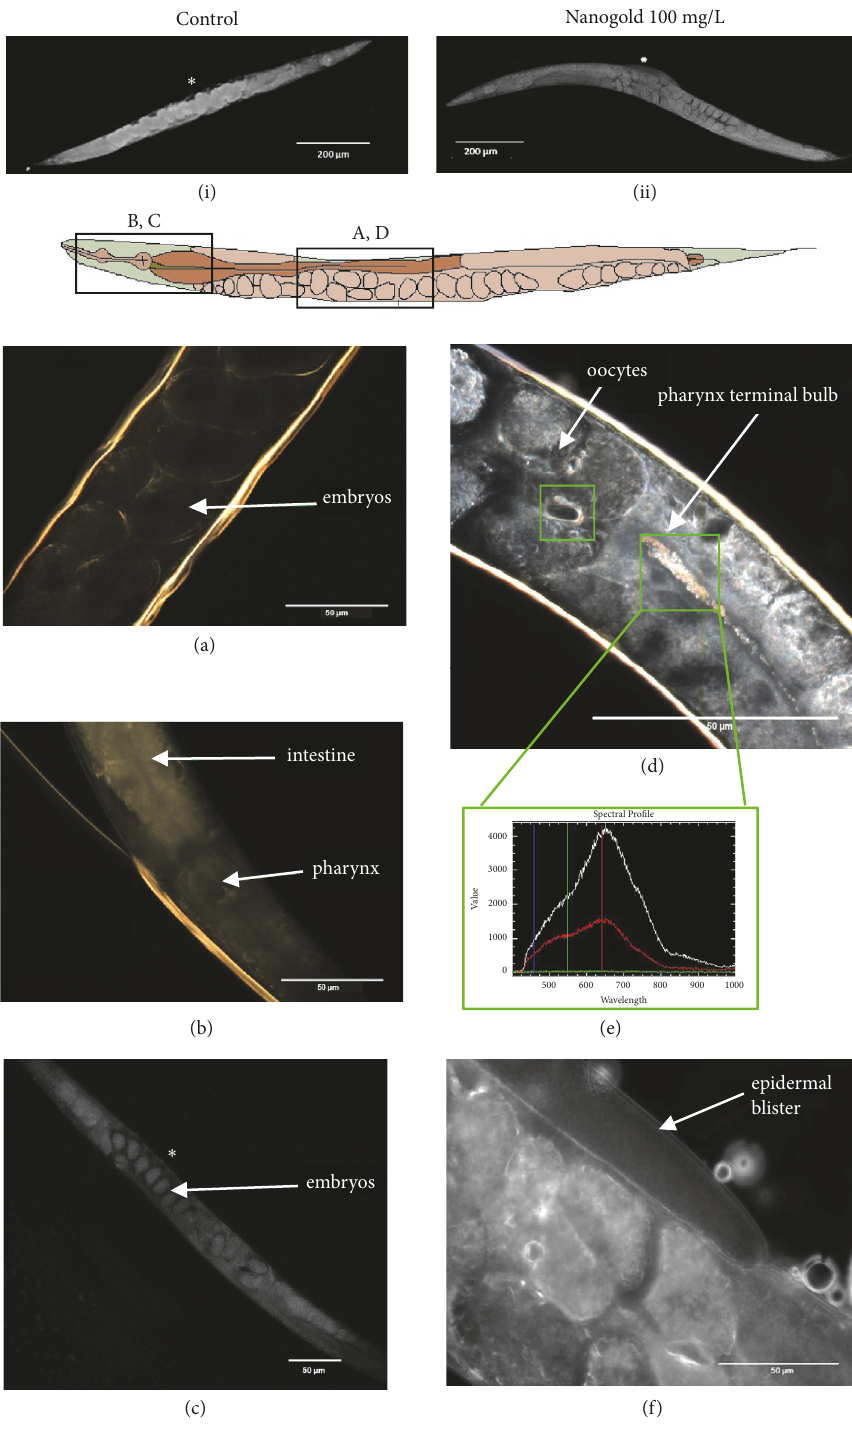
Figure 2: CELLDISCOVERER 7 images (i, ii, c) and CytoViva (cid:2) Darkfield images of control nematodes (a and b) and a nematode exposed to the highest concentration nanogold (ii, d, f). The image also indicates the section of the organism where images are located as well as the spectral profile (e), indicating gold present in the pharynx and oocytes (d). Epidermal blisters were also observed around the vulva area (f). Asterisk indicates the